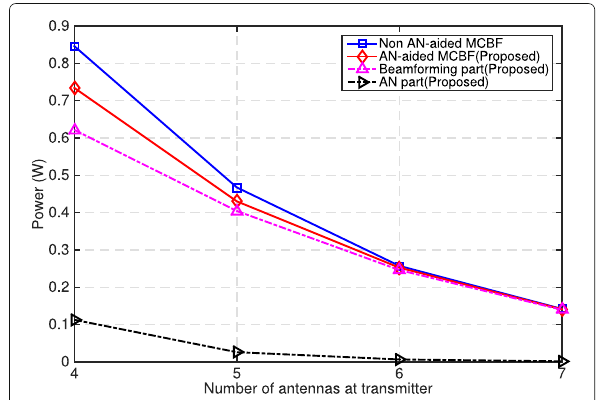
Fig. 6 Required power versus number of transmit antennas